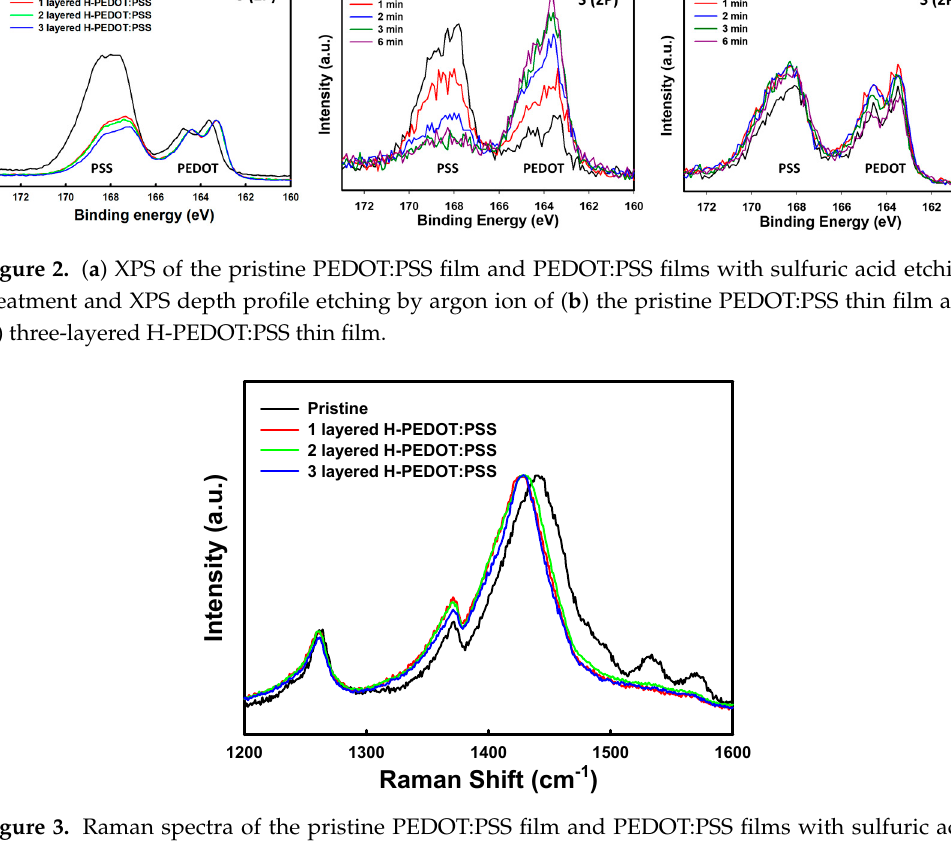
Figure 3. Raman spectra of the pristine PEDOT:PSS film and PEDOT:PSS films with sulfuric acid etching treatment (under 632.8 nm He–Ne laser excitation).